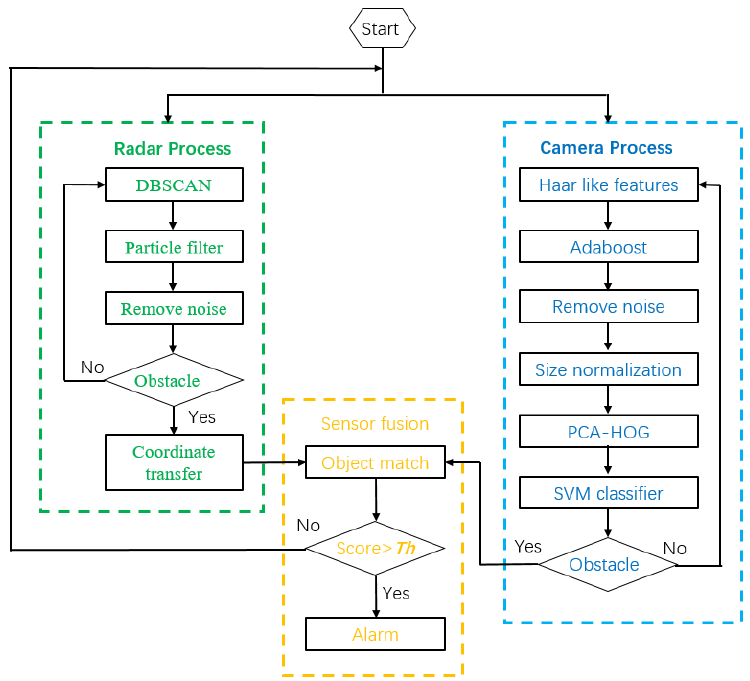
Figure 1. Overall architecture of an on-road obstacle detection system.